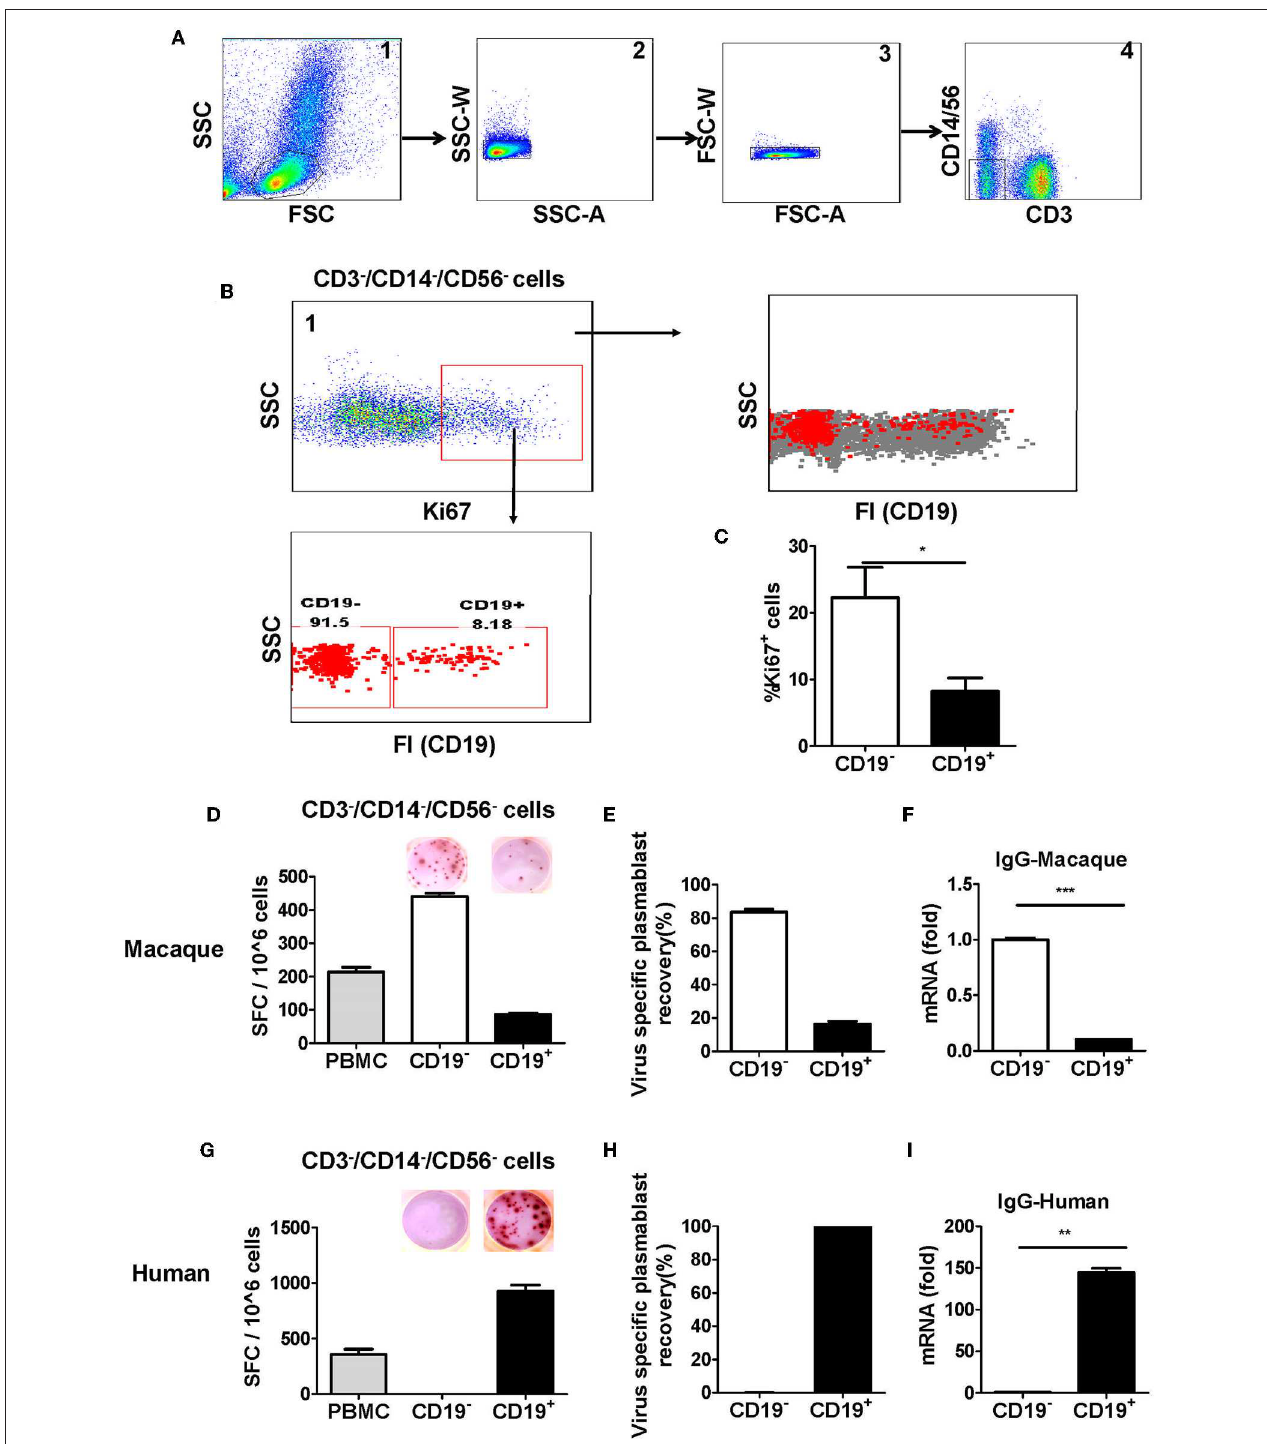
FIGURE 2 | Antibody-secreting plasmablasts from Chinese rhesus macaques are primarily Ki67 + CD19 − cells. A gating strategy was designed to exclude lineage cells (CD3 + T cells, CD14 + monocytes, and CD56 + NK cells) and the remaining cells were analyzed for intracellular Ki67. (A) Representative flow cytometry analysis showing the following sequential gating strategy to enrich possible plasmablasts: (1) extended lymphocyte gate that included plasmablasts; (2, 3) singlets; (4) CD3 − CD14 − CD56 − cells. (B) Representative flow cytometry analysis showing CD19 expression on the surface of intracellular Ki67 + cells. (C) Flow cytometry analysis showing the percentage of intracellular Ki67 + cells among CD19 − and CD19 + cells ( n = 4, Mean ± SEM). PBMCs from rhesus macaques (D,F) ( n = 4) and